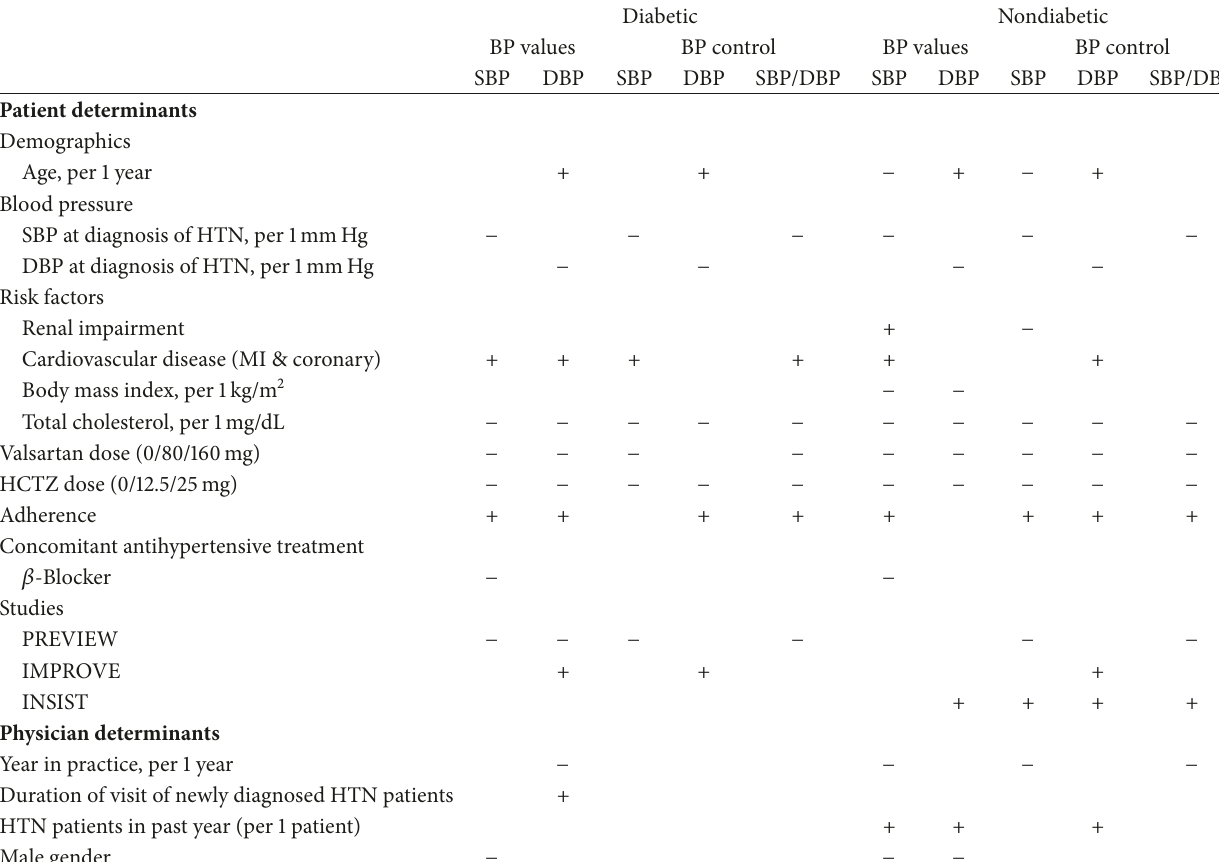
Table 6: Summary of determinants retained in hierarchical linear and logistic regression modeling (any occurrence of